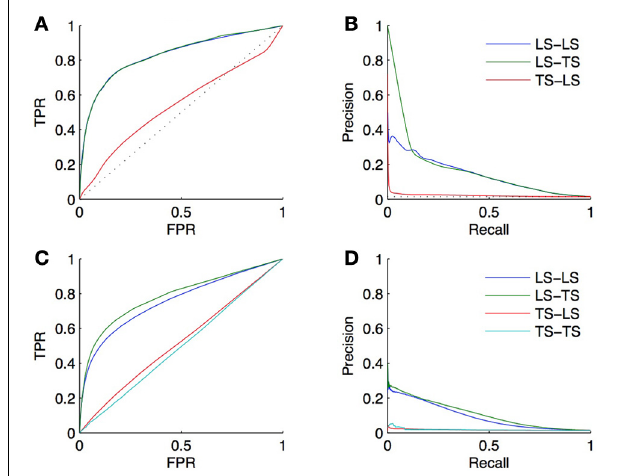
FIGURE 10 | The heavy-tailed degree distribution of many biological networks can lead to better than random predictions, only by exploiting the network topology and ignoring node or pair features. First row: ROC curves (A) and PR curves (B) obtained from predictions made on the DREAM5 dataset using the degree of the nodes in the learning set. Second row: ROC curves (C) and PR curves (D) obtained from predictions made on the DREAM5 dataset when randomly permuting the feature vectors relative to different